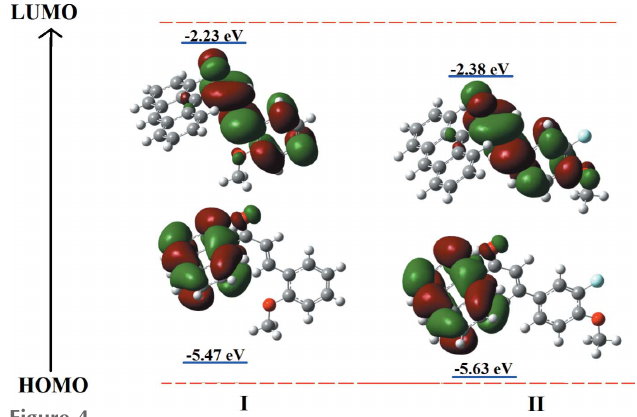
Figure 4 Molecular orbital electron distributions of the HOMO and LUMO energy levels for (I) and (II).